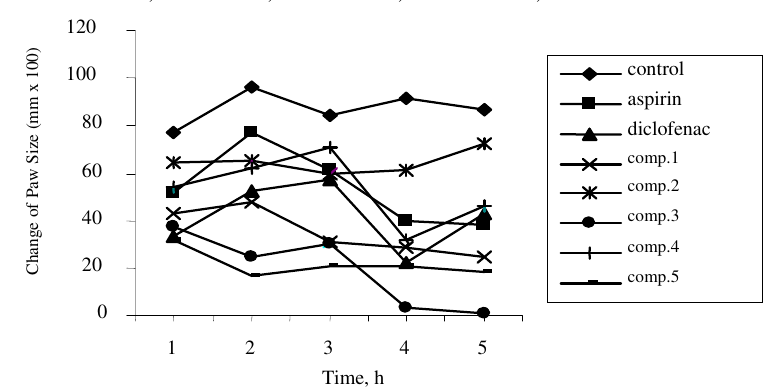
Figure 9. Formalin induced inflammation tests of histidine